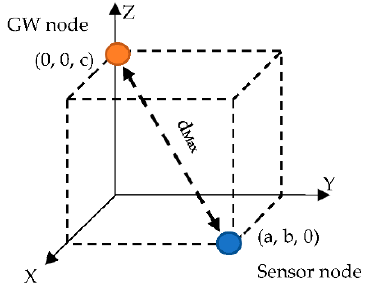
Figure 3. Maximum distance in a 3D box.